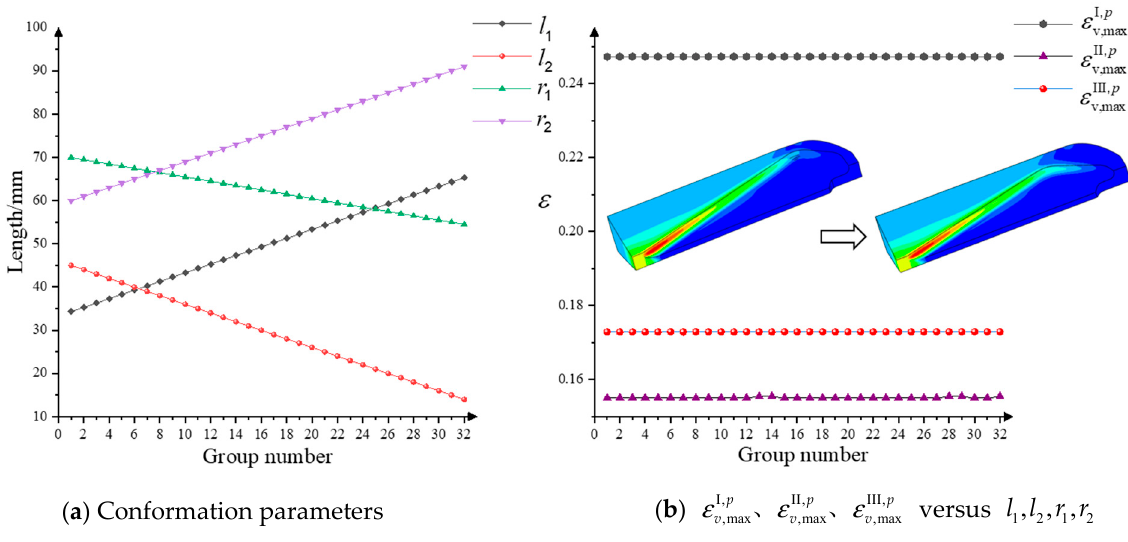
, , , l l r r . Figure 9. The relationship map between ε I, p v ,max , ε II, p v ,max , ε III, p v ,max and l 1 , l 2 , r 1 , r 2 1 2 1 2